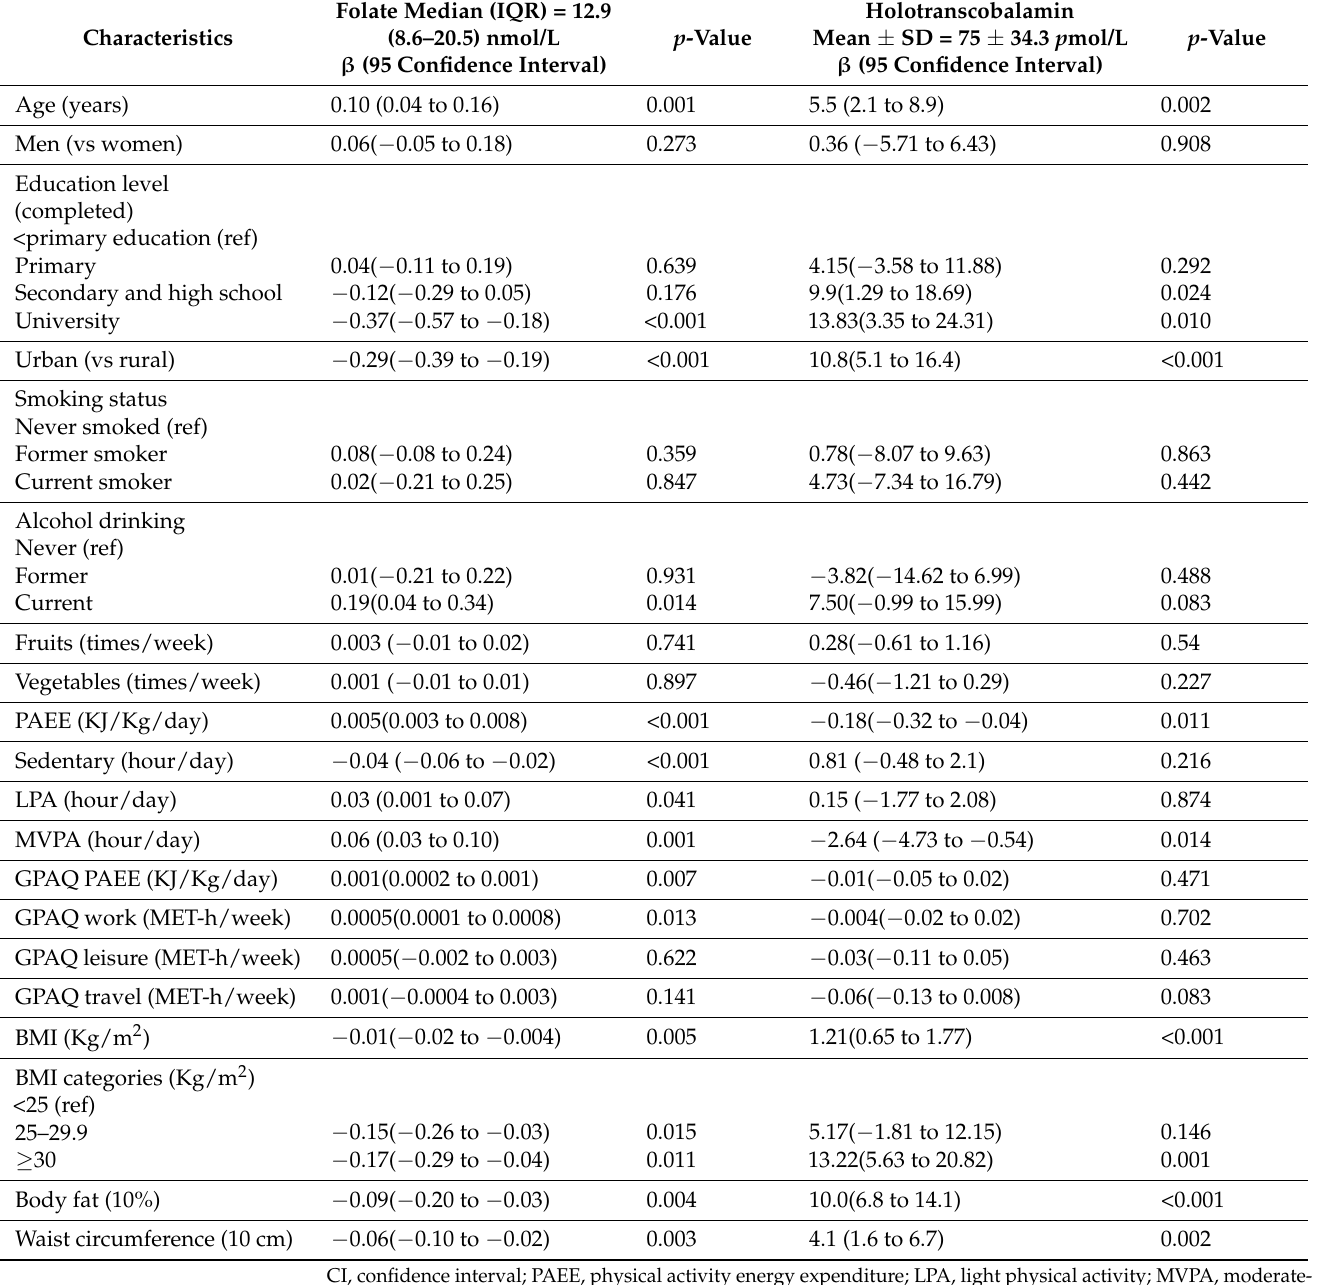
Table 1. Factors associated with serum folate ( n = 578) and holotranscobalamin ( n = 547); Cameroon